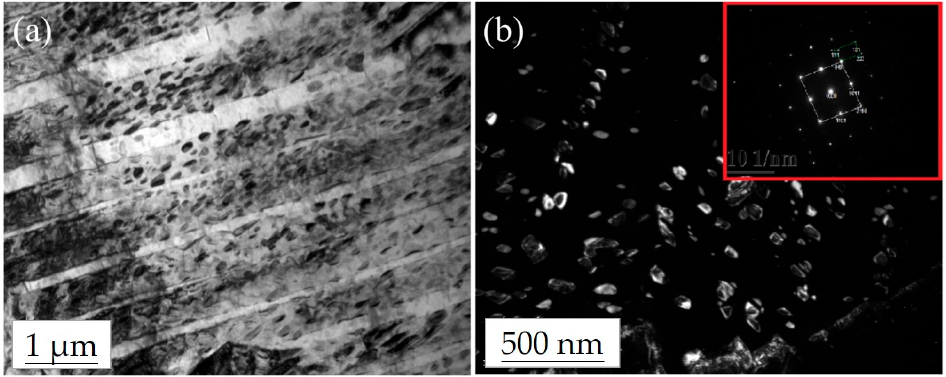
Figure 5. TEM (transmission electron microscopy) images, including: ( a ) Bright field image and ( b ) Dark field image. The smaller image is the [011] axis of the selected area diffraction pattern (SADP), which shows the presence of nano-sized particle precipitates after precipitation hardening of the material.